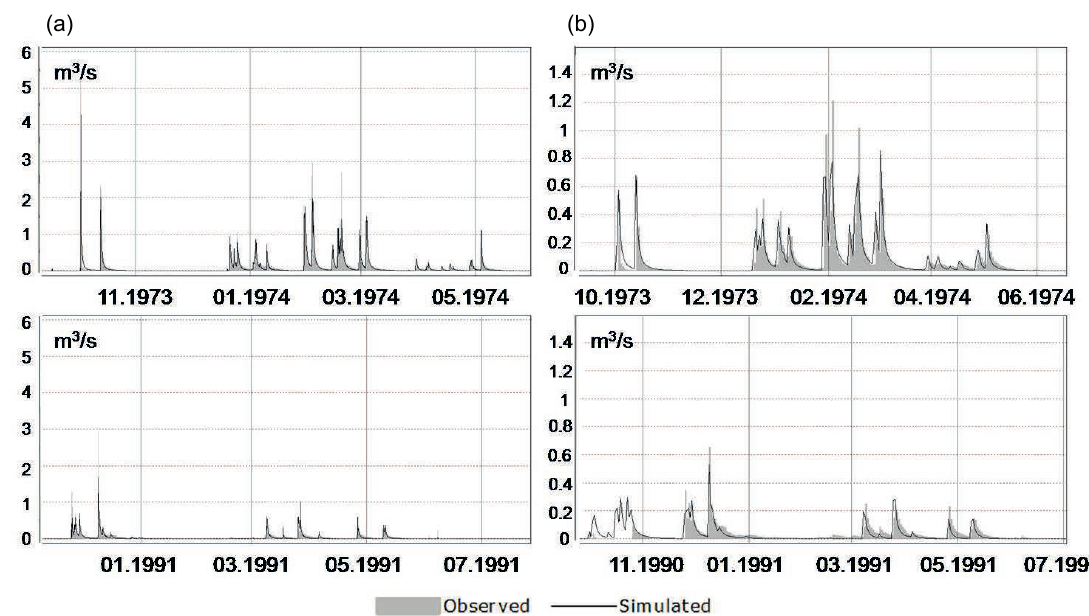
Fig. 2 Simulated and observed hydrographs for pre- and post-fire periods simulated on daily (a) and hourly (b) time